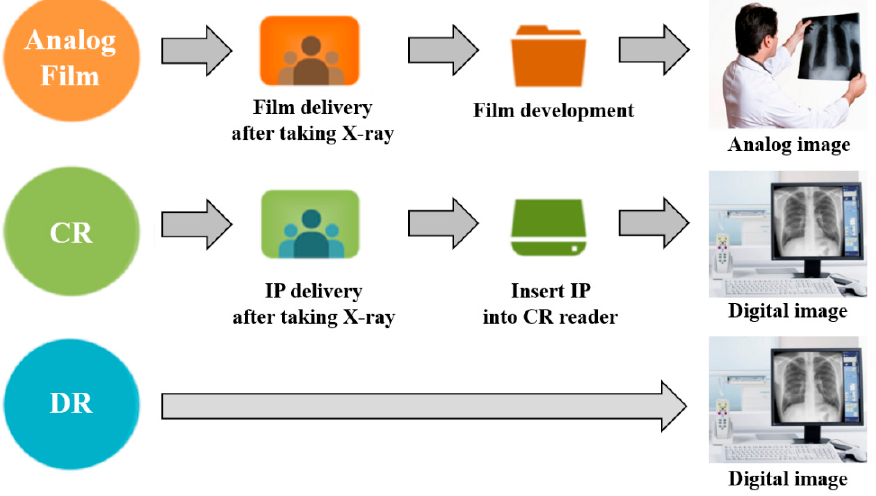
Figure 1. Workflow of the X-ray detection methods.